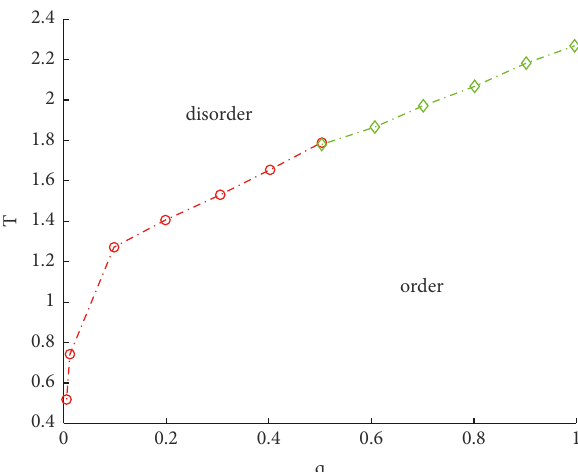
Figure 5: Phase diagram of model: discontinuous phase change occurs on the red representative system, and the continuous phase change occurs on the green representative system. q describes the individual’s identity to the surrounding public opinion environ-